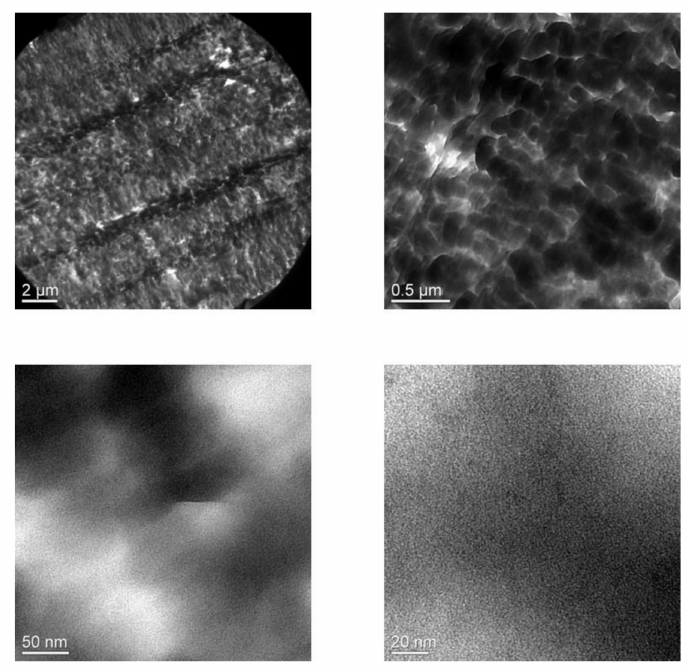
Figure 4. TEM images of the representative GPERM (PEGMA500_10).